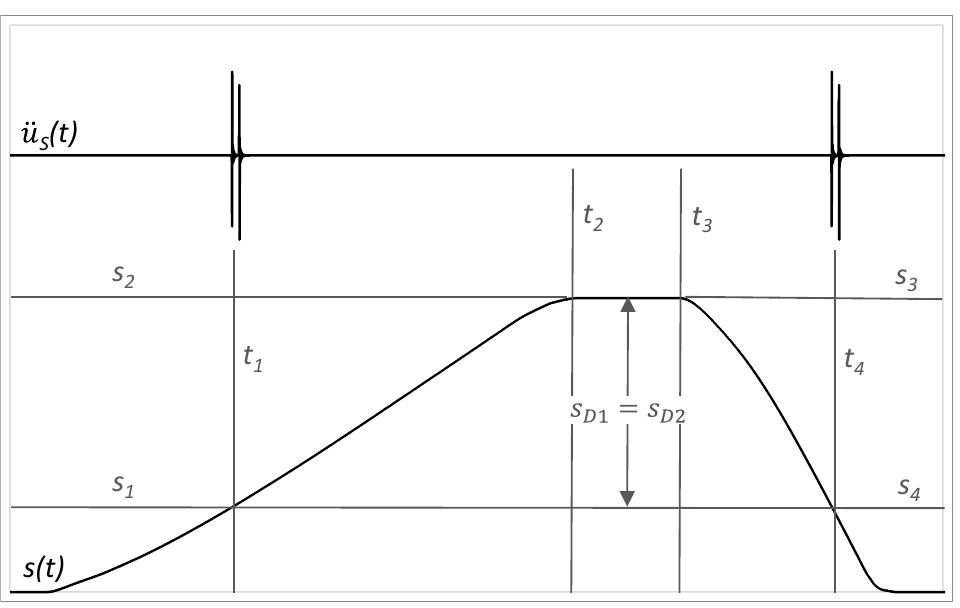
Figure 15. Acceleration amplitudes of vibrations in the context of distance by the damage of guid- ing profile.